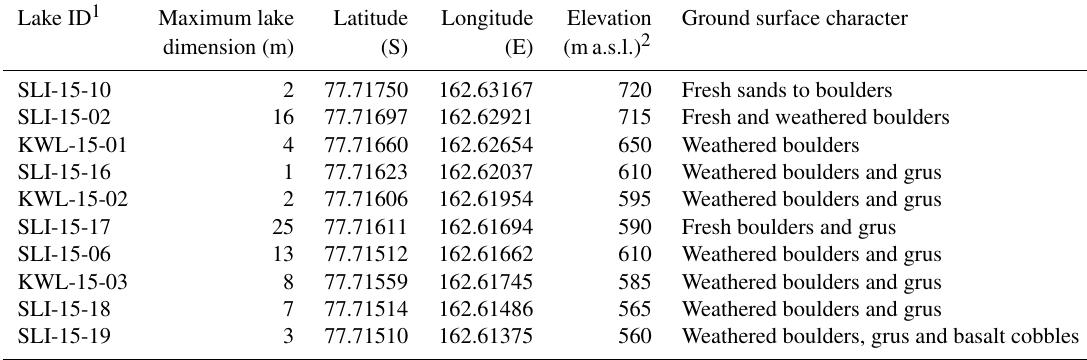
Table 2. Location and description of sampled meltwater ponds.